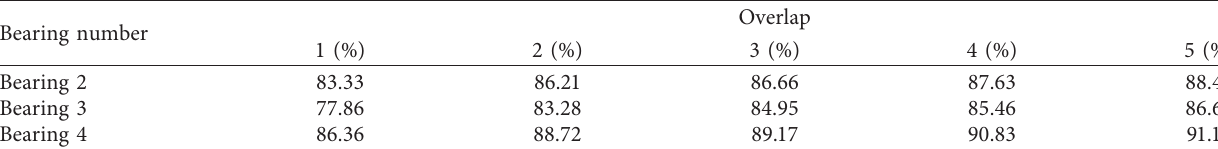
Figure 12: Temporal distribution graph of the overlap. (a) Bearing no. 2. (b) Bearing no. 3. (c) Bearing no. 4. Table 2: Five minimum overlaps of bearings no. 2 to no.